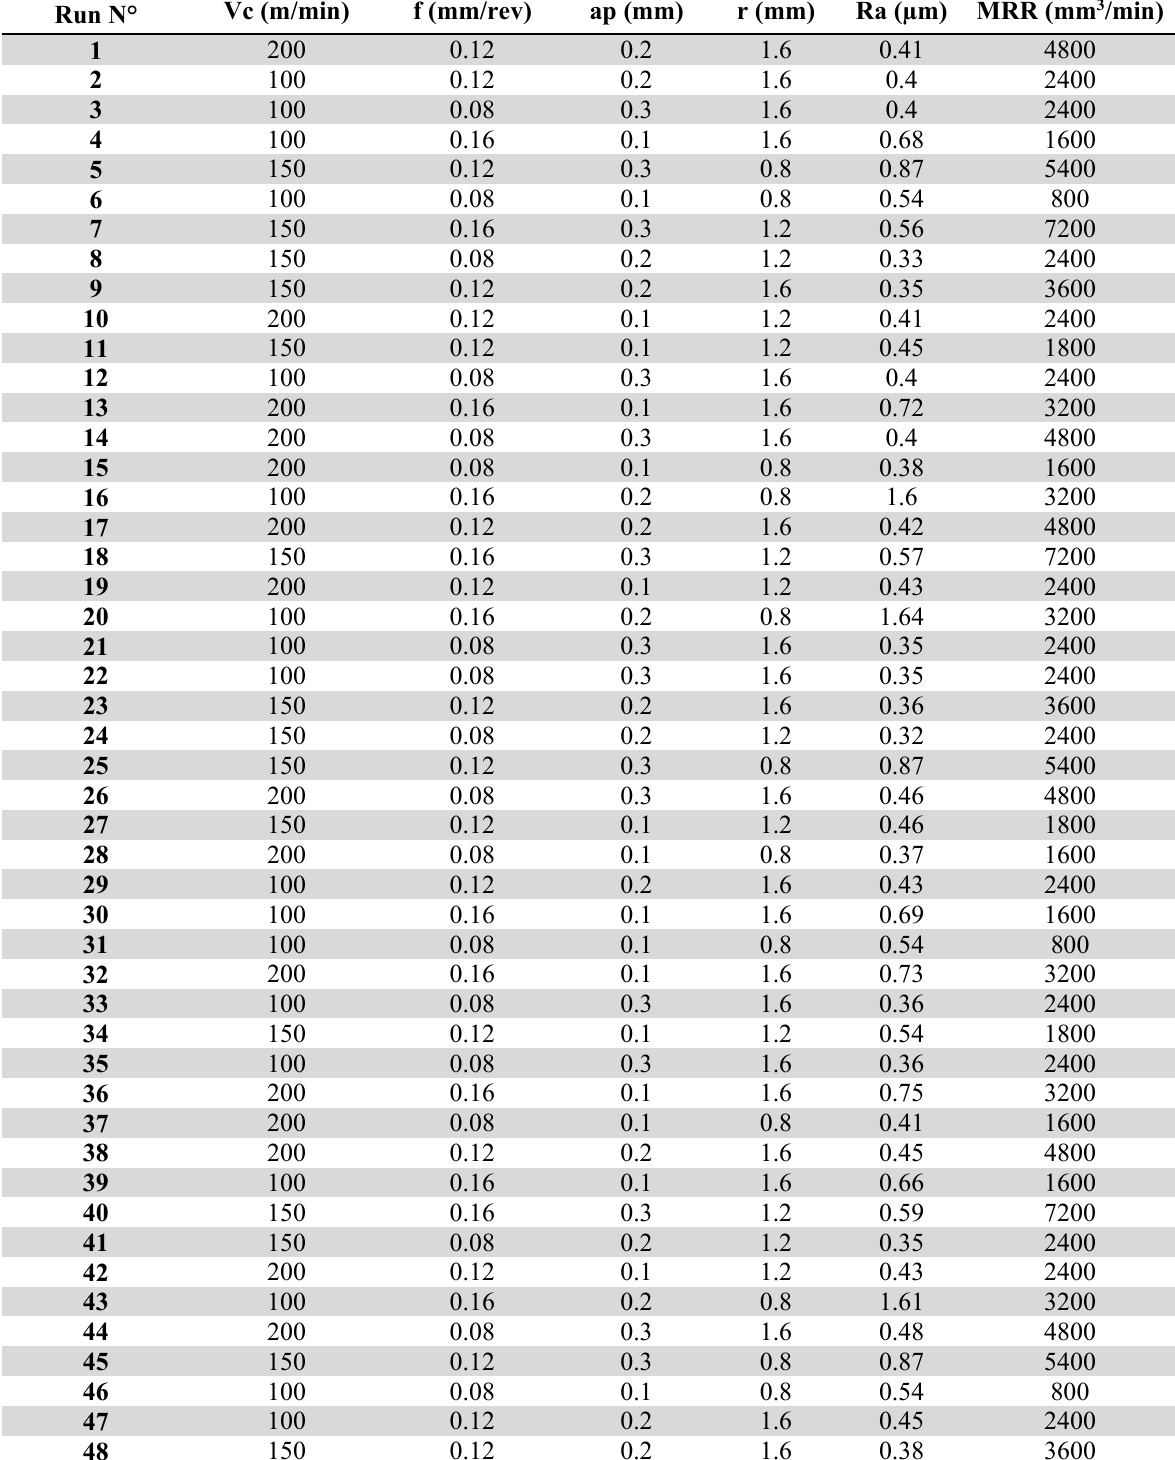
Experimental results for surface roughness and